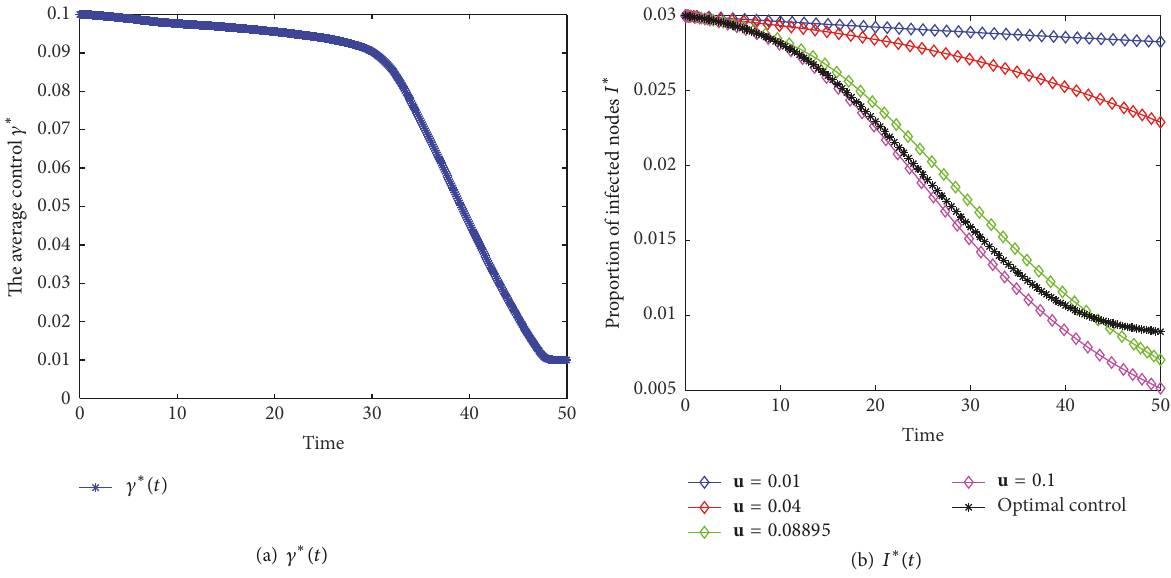
Figure 2: 𝛾 ∗ (𝑡) and 𝐼 ∗ (𝑡) under different control strategies with 𝑚 1 = 𝑚 2 = 2 for Example 1.